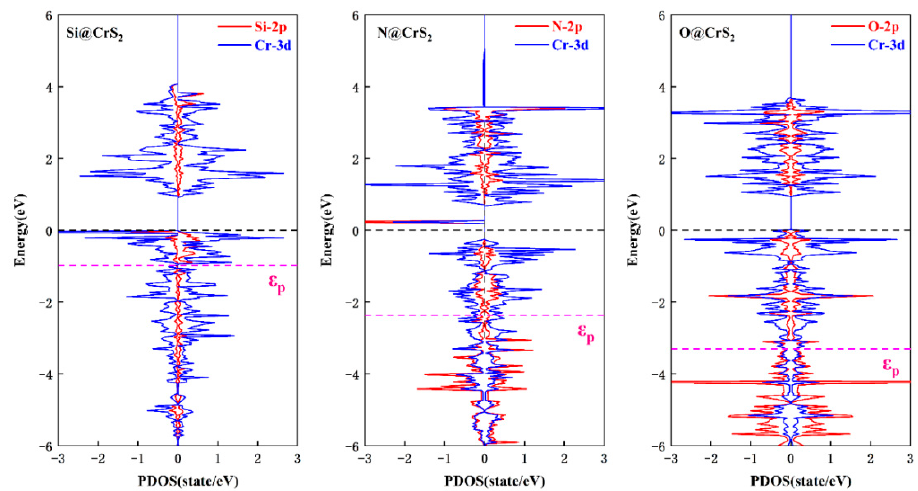
Figure 5. The computed partial density of states for Si@CrS 2 , N@CrS 2 , and O@CrS 2 . The black and pink vertical dotted lines represent the Fermi energy level and p-band center ( ε p ), respectively.